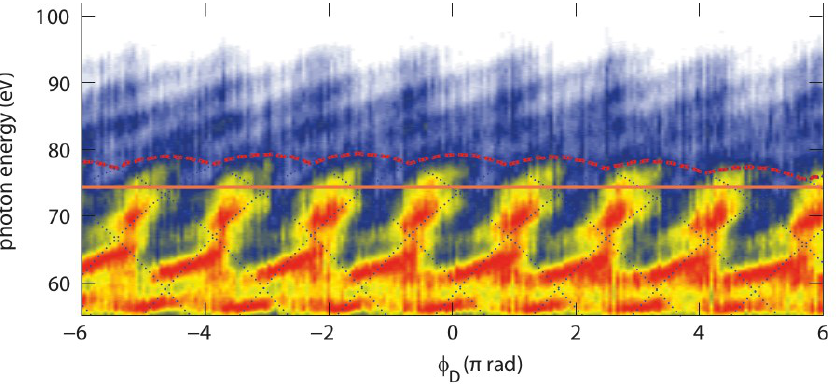
Fig. 1. CEP-scan: HHG spectra recorded over many CEP periods. The cut-off energy is calculated with the intensity model ([3], dashed red line). The half-cycles cut-offs are given as dotted blue lines. (adapted from